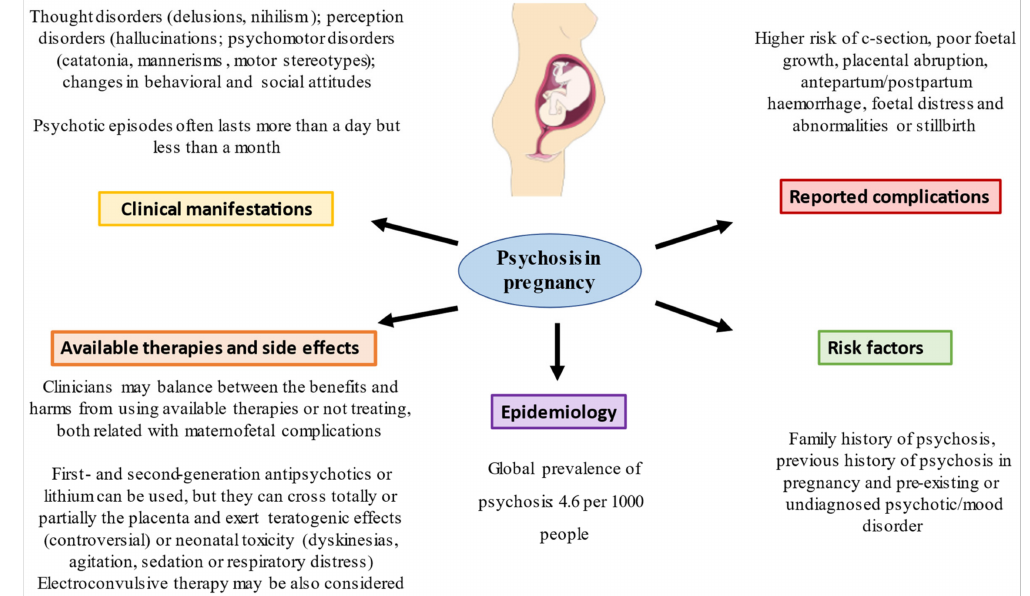
Figure 1. A summary of the main data of psychosis in